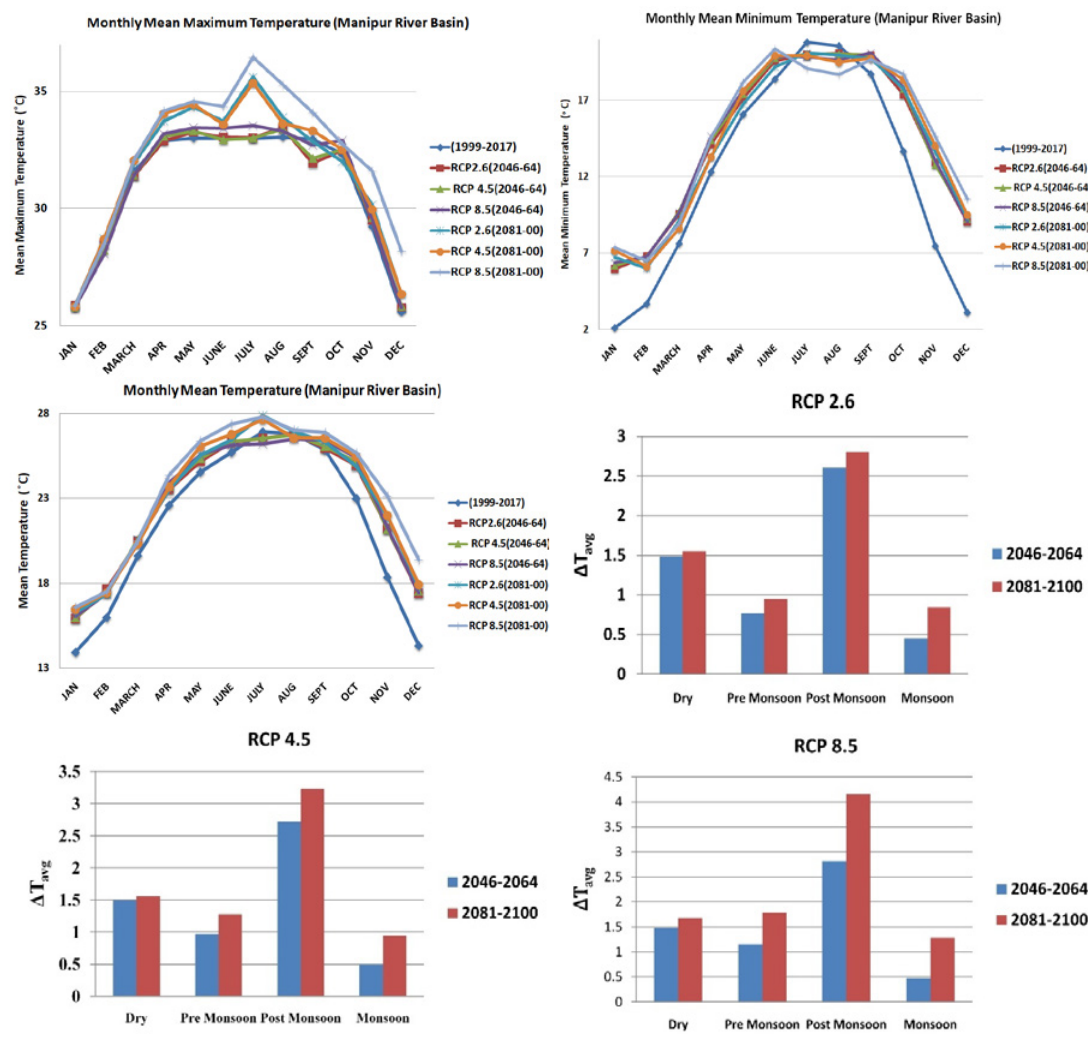
Fig. 6: Monthly average maximum temperature, monthly average minimum temperature and monthly average temperature under three different RCP scenarios for the time period 2046-2064 and 2081-2100. Variation in temporal average temperature under different scenarios